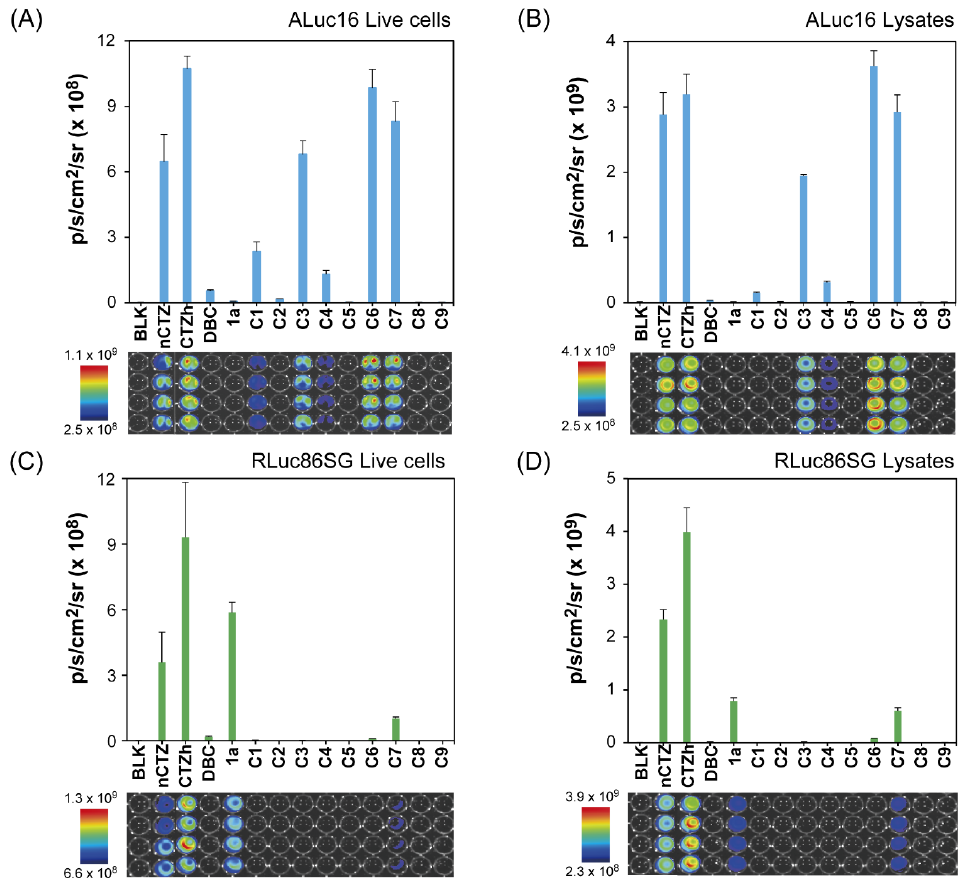
Figure 2. Characterization of CTZ analogues C1 – C9 . ( A ) The absolute BL intensities of ALuc16 in lysates according to CTZ analogues. ( B ) The absolute BL intensities of RLuc8.6SG in lysates according to CTZ analogues. ( C ) The absolute BL intensities of ALuc16 in live cells according to CTZ analogues. ( D ) The absolute BL intensities of RLuc8.6SG in live cells according to CTZ analogues. The bottom panels show the corresponding BL images.